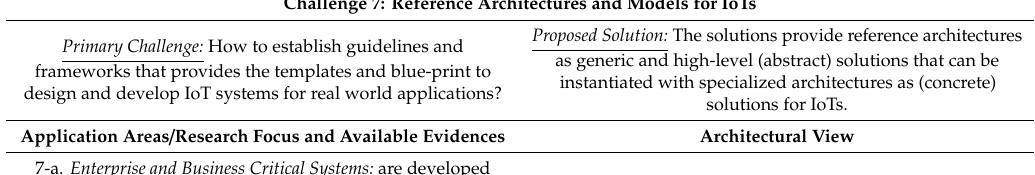
Table 11. Challenge VII— Overview of the challenges and solutions for reference architecture and models for IoTs. Challenge 7: Reference Architectures and Models for